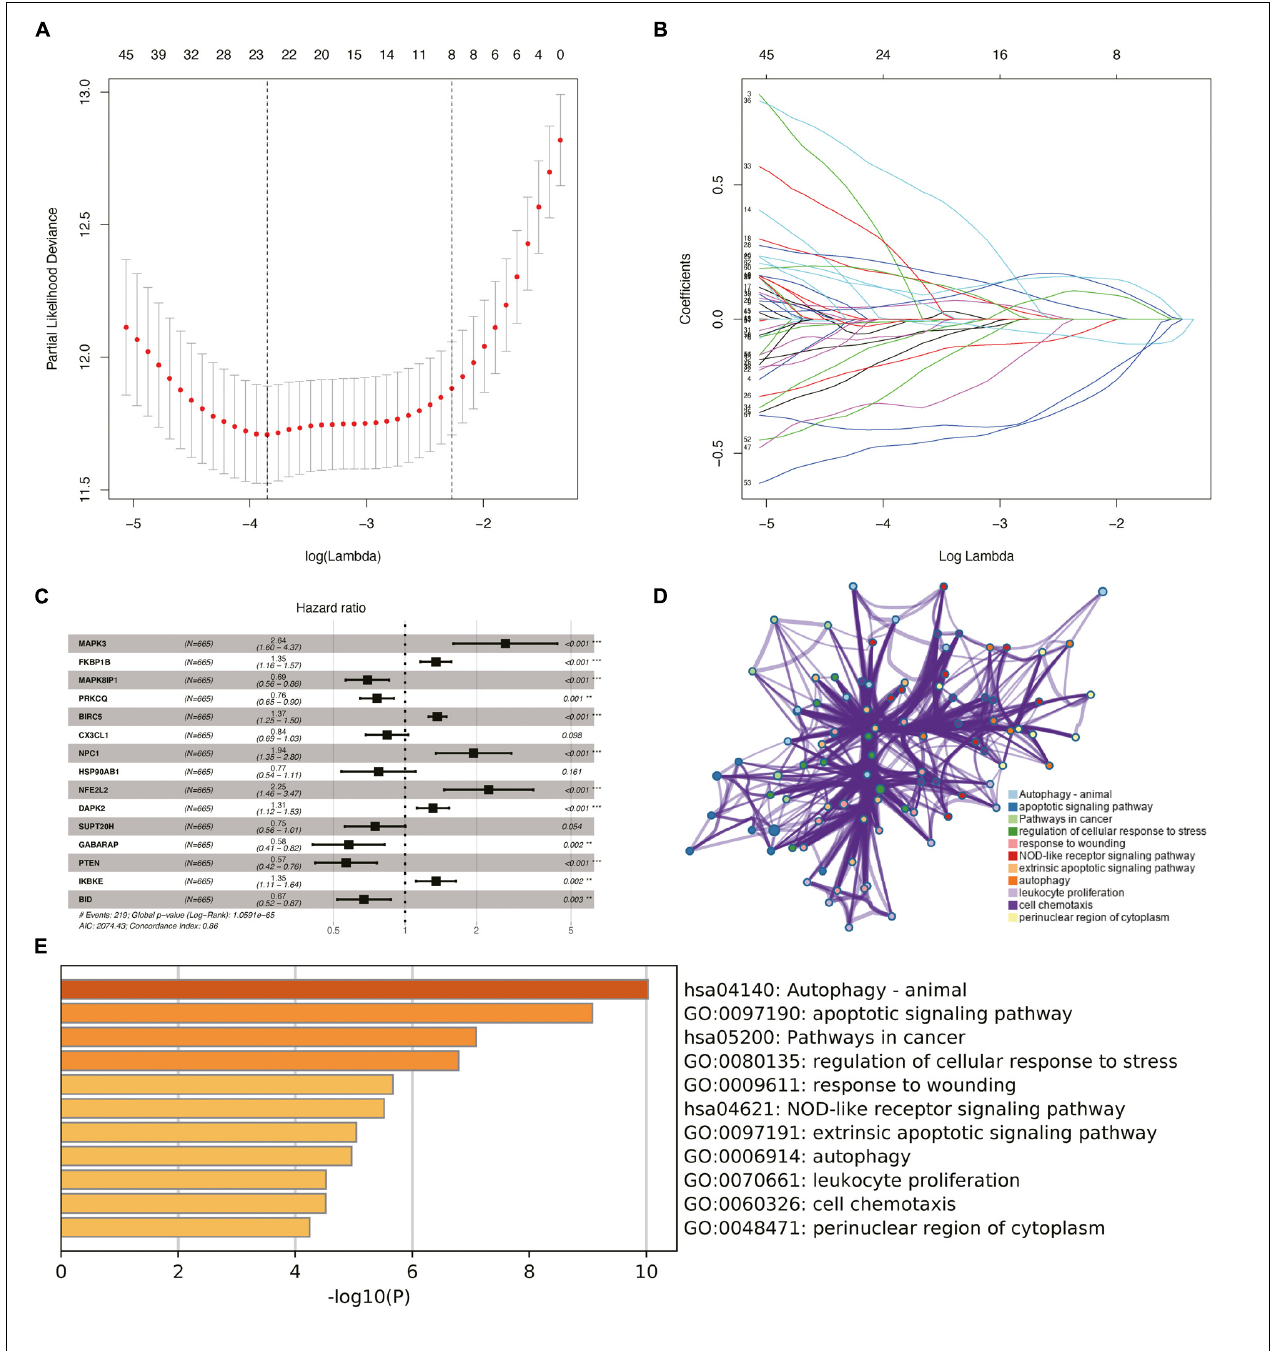
FIGURE 2 | Construction of the prognostic risk model and biological function analysis. (A) Cross-validation for tuning parameter screening in the least absolute shrinkage and selection operator (LASSO) regression model. (B) LASSO coefficient profiles of the common genes. (C) Risk genes in the prognostic risk model. (D) The functional enrichment map of pathways of risk genes. Each node indicates an enriched term and is colored by its cluster ID. (E) Enriched pathways of the genes positively correlated with risk genes.